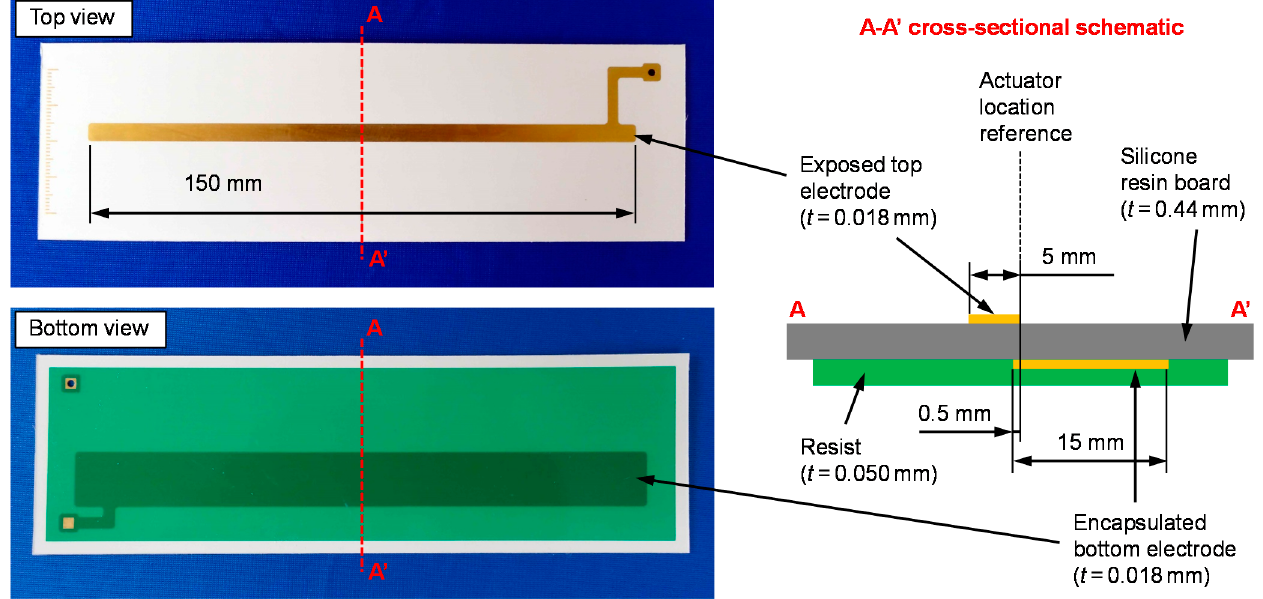
Figure 5. Photographs of the top and bottom views ( left ) and cross-sectional schematic ( right ) of the plasma actuator.